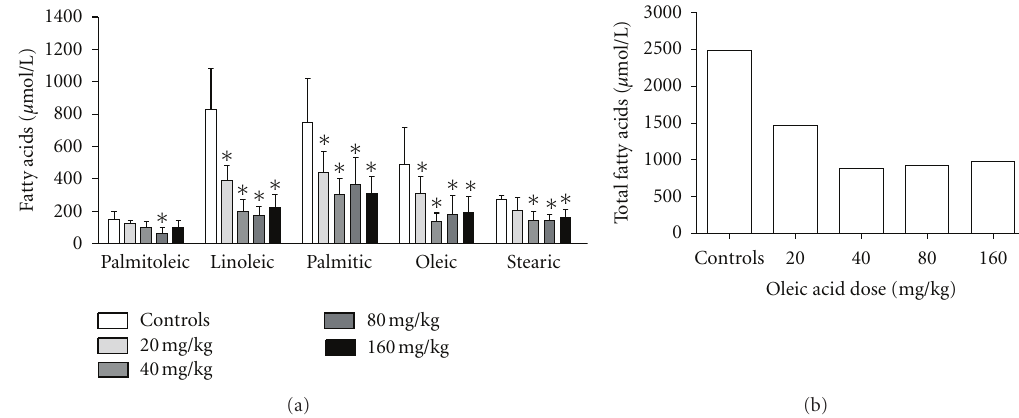
Figure 4: Plasma NEFA concentrations after OLA administration by the gastric route. (a) Plasma concentrations of palmitoleic, linoleic, palmitic, oleic, and stearic acids 24 h after 20, 40, 80, and 160 mg/kg oleic acid doses; (b) total NEFA concentration (sum of average concentrations of the five NEFA). Results represent data from 5 independent experiments (mean ± SEM). ∗ P < 0 .